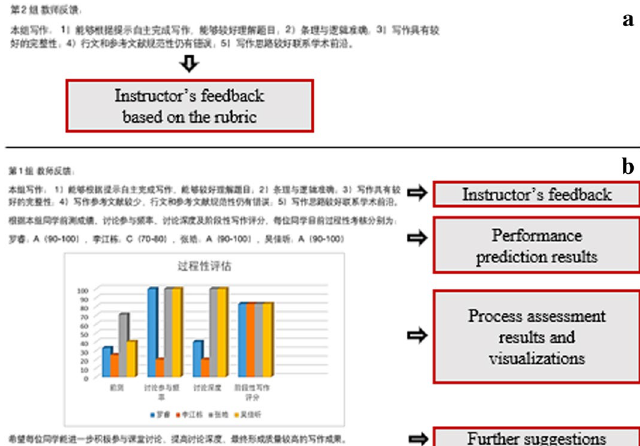
Fig. 2 The integrated AI and LA